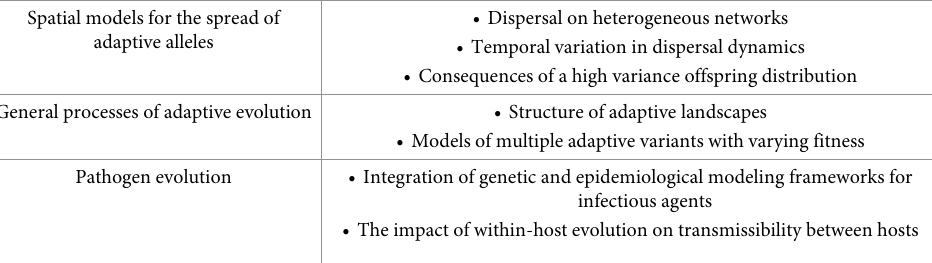
Table 2. Ongoing challenges for future work in theoretical models of the spread of adaptive viral variants. Spatial models for the spread of adaptive alleles • Consequences of a high variance offspring distribution General processes of adaptive evolution • Models of multiple adaptive variants with varying fitness Pathogen